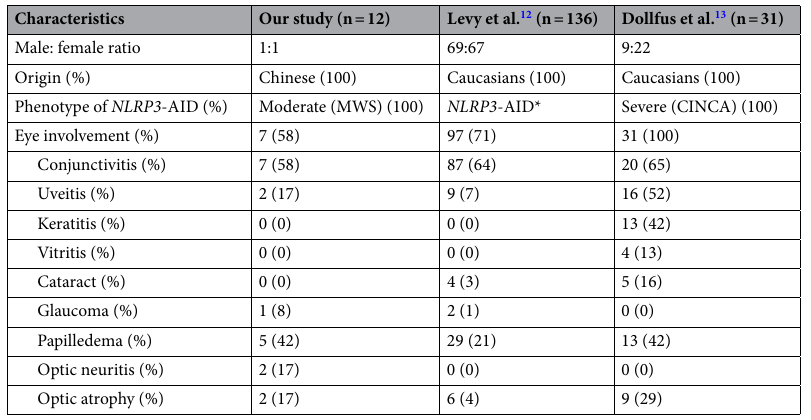
Table 2. Comparison of phenotypic features among reported cohorts. *Not given in